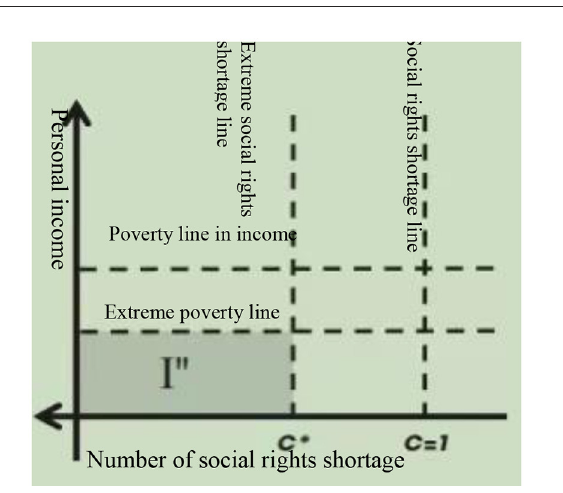
FIGURE2 Extremely multidimensional poverty. Source: Consejo Nacional de Evaluación de la Política de Desarrollo Social (7) Page 38. have strong resistance to unfavorable environment.